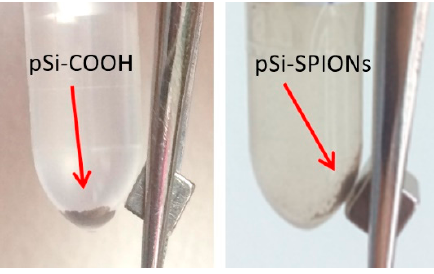
Figure 8. Evidence of the pSi-SPIONs microparticles, highlighted by an arrow, magnetic properties, differently from pSi-COOH microparticles, not attracted by the magnet.